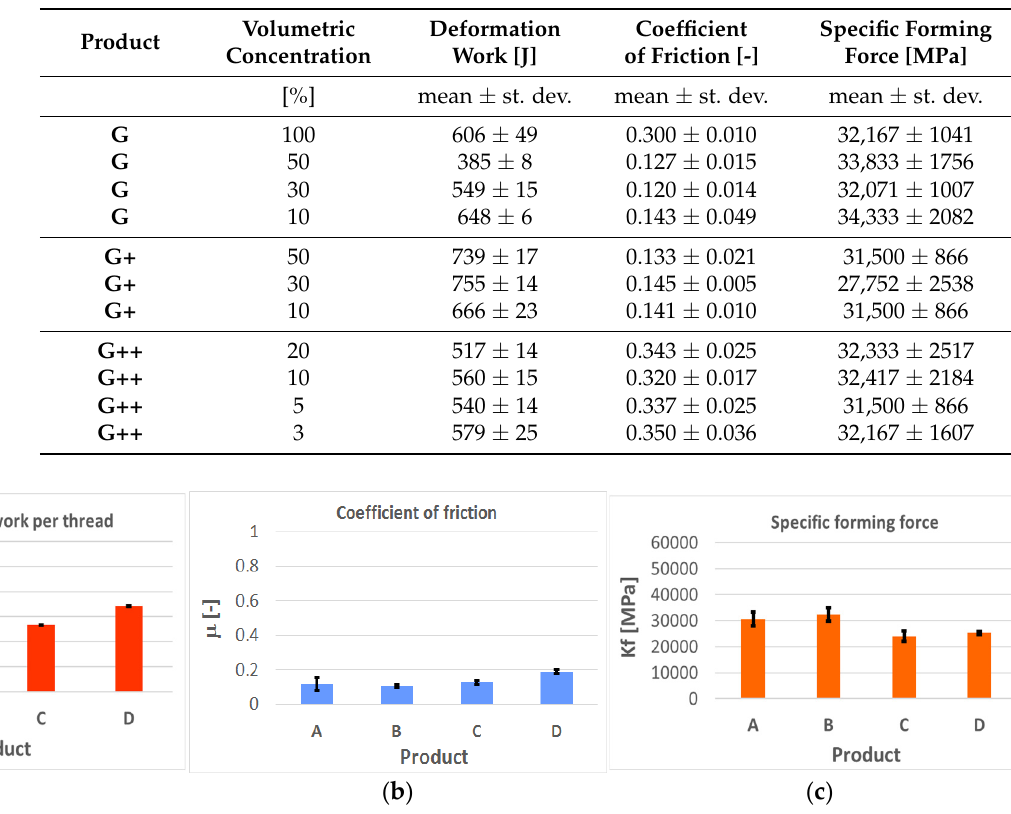
Figure 10. Deformation works, coefficient of friction, and specific forming force for the polymers